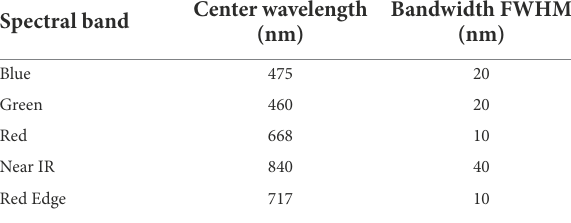
TABLE 1 Specific parameters of the spectral